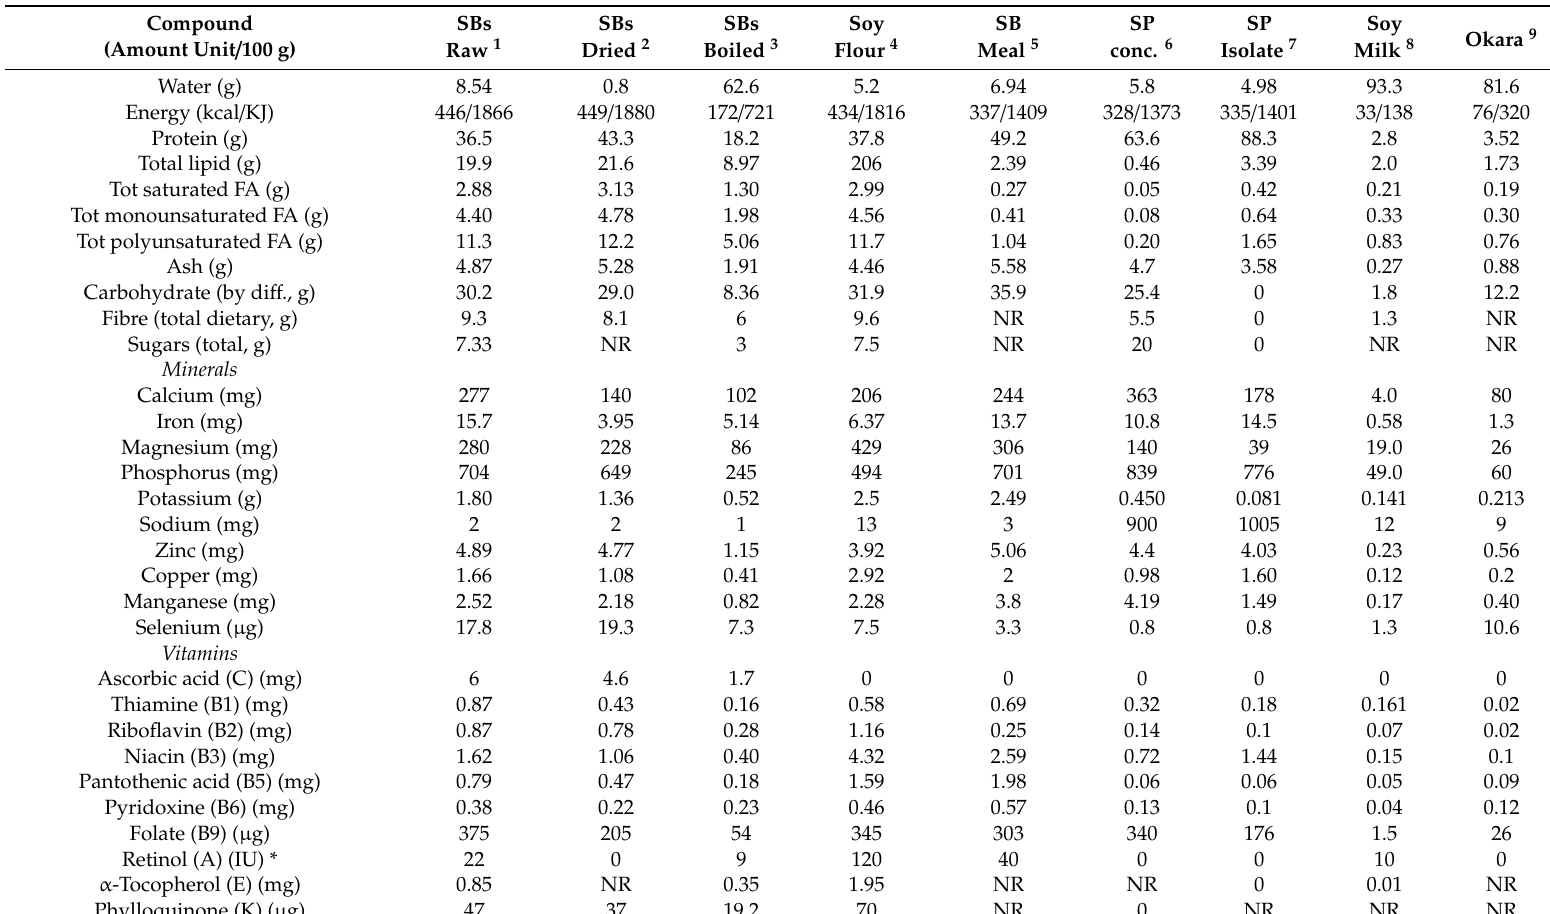
Table 1. Nutritional composition of traditional unfermented soy-based foods, such as fresh, dried and boiled soybeans (SBs), soy flour, SBs meal, soy protein (SP) concentrate and isolate, soymilk and okara (100 g portion, based on USDA Nutrient Database)